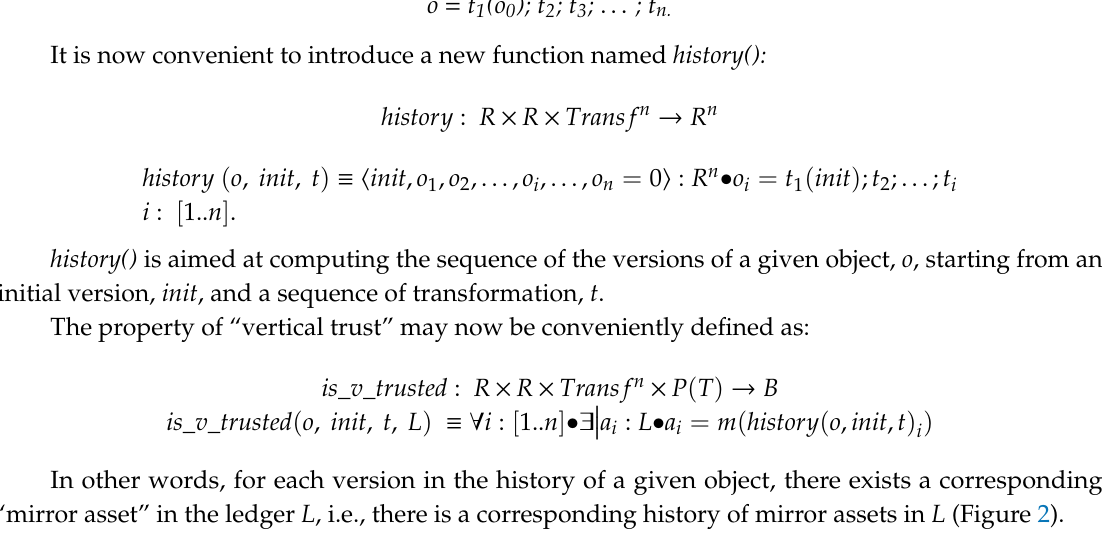
Figure 2. Mirror